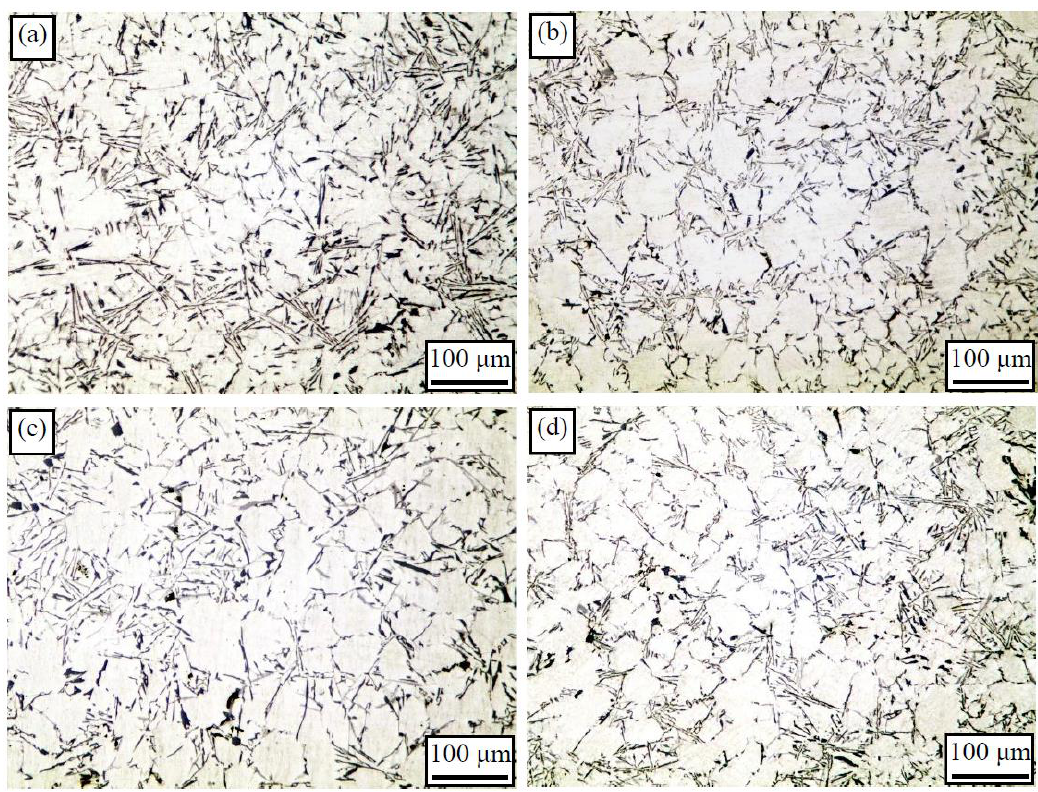
Figure 8. Optical micrographs of as-cast gravity casting A1 alloys treated by different physical fields: ( a ) no treatment; ( b ) UV; ( c ) ES; ( d ) UV-ES.